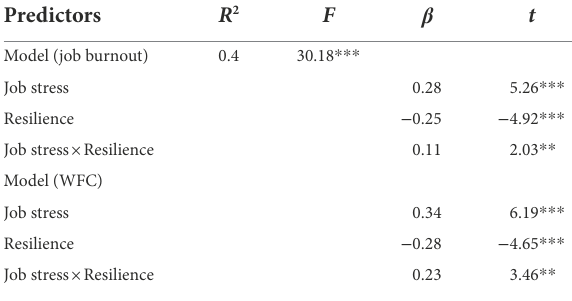
TABLE 3 Testing the moderated mediation effect of job stress on burnout.